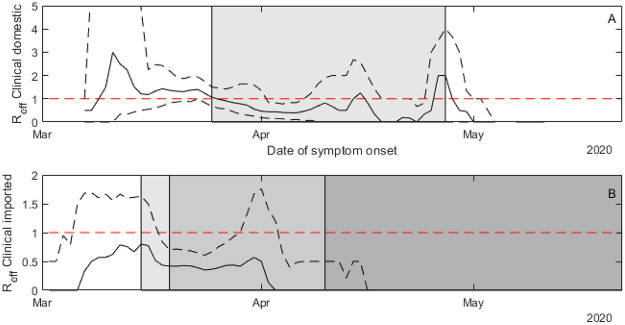
Increases in alert level and improved border measures resulted in decreases in secondary transmissions.Expected value of Reff each day for clinical domestic cases (A) and imported cases (B). Solid line show the median from 500 instances of the reconstructed transmission tree, dashed lines are the 95% range. Imported cases had a lower effective reproduction number than domestic cases. The date of secondary case exposure was assigned to be the date of symptom onset in the index case. Note that 10–13 April was the long Easter weekend and 27 April was a public holiday in New Zealand. The timing of the end of alert level four was announced on 22 April. Shading in (A) shows period of alert level 4 (26 March to 27 April). Shading in (B) shows progressively stricter border restrictions introduced 16 March, 20 March and 10 April.